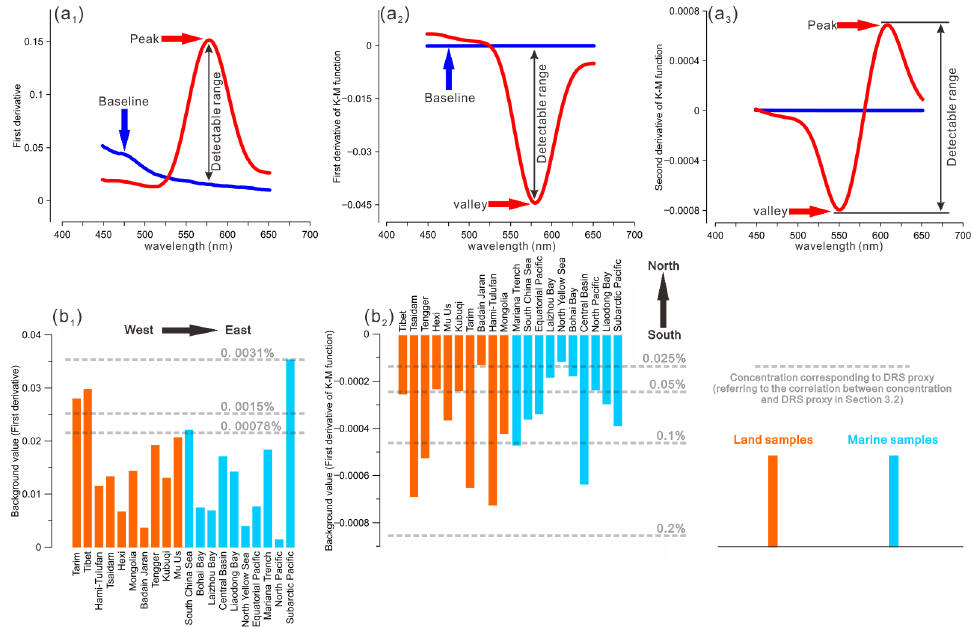
Figure 6. Extracting mechanism (of DRS proxy) and background influence of ( a 1 – b 1 ) the first derivative, ( a 2 – b 2 ) the first derivative of the K–M function, and ( a 3 ) the second derivative of the K–M function.